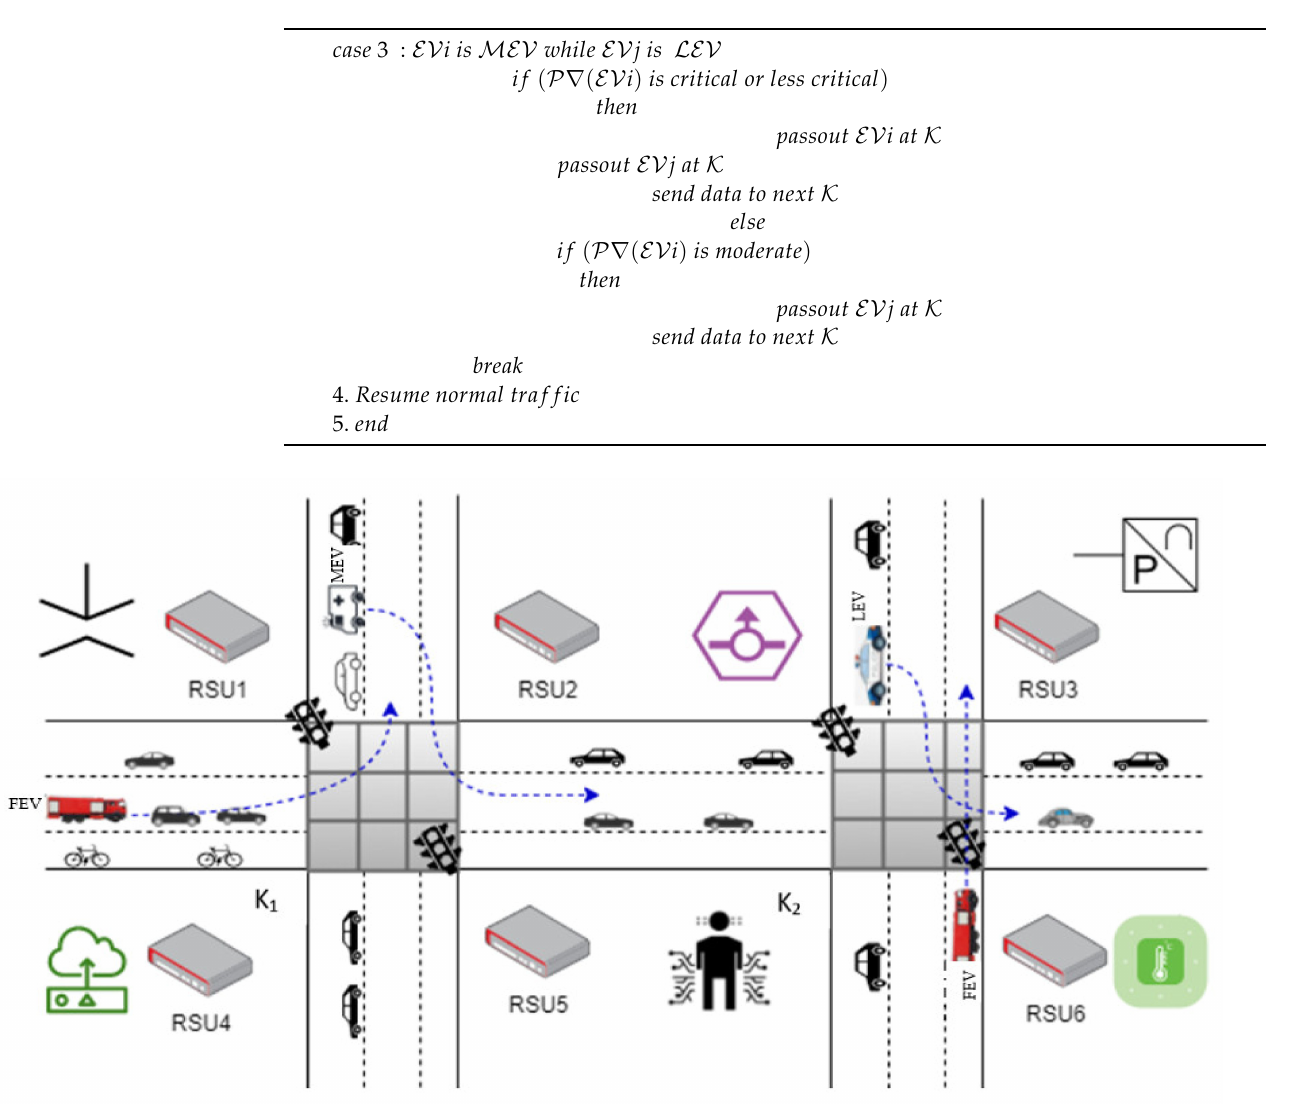
Figure 4. Case 2, mentioned in Algorithm 1 (when both vehicles have the same